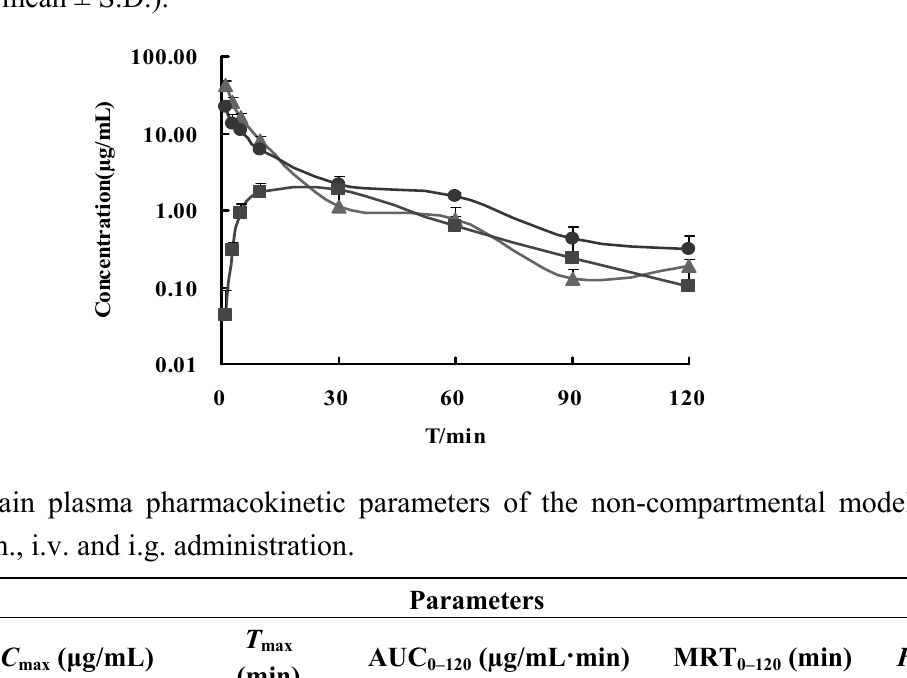
Figure 4. Mean plasma concentration-time curve of Ge (18 mg/kg of gardenia extract combined with 18 mg/kg of borneol) via i.n. ( ● ); i.v. ( ▲ ) and i.g. ( ■ ) administration in mice ( n = 5, mean ± S.D.).